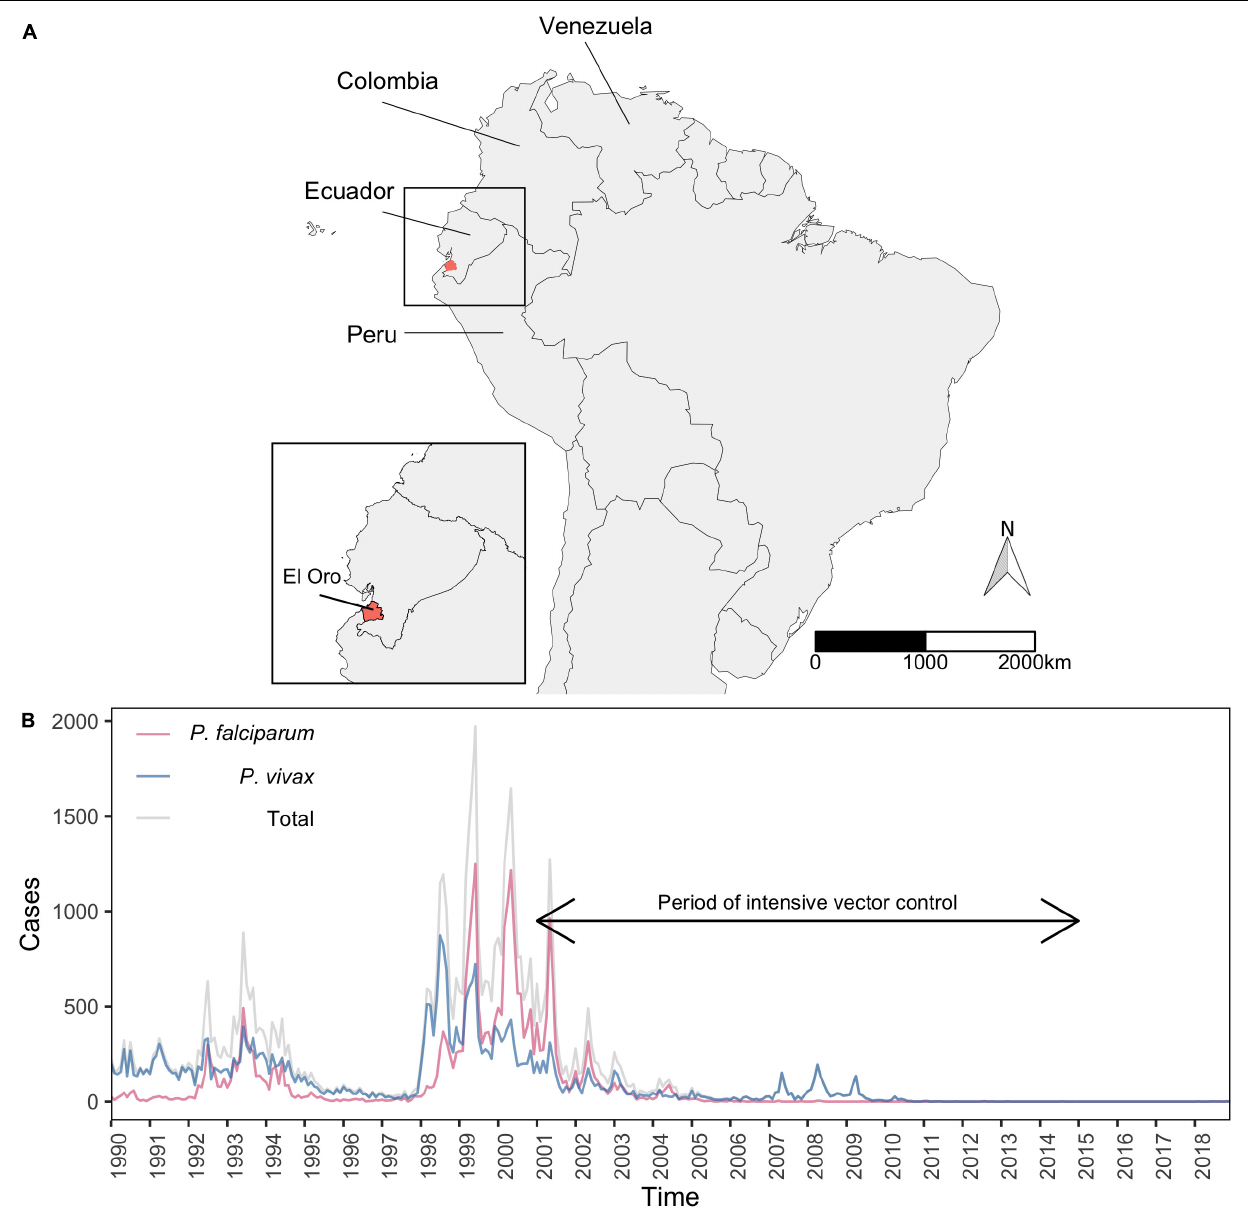
FIGURE 1 | Malaria cases in El Oro 1990–2018. (A) Location of El Oro province (red), Ecuador in relation to neighboring countries in South American; Colombia, Peru, and Venezuela. (B) Total number of malaria cases (gray), cases of P. falciparum (pink), and P. vivax malaria (blue) recorded in El Oro